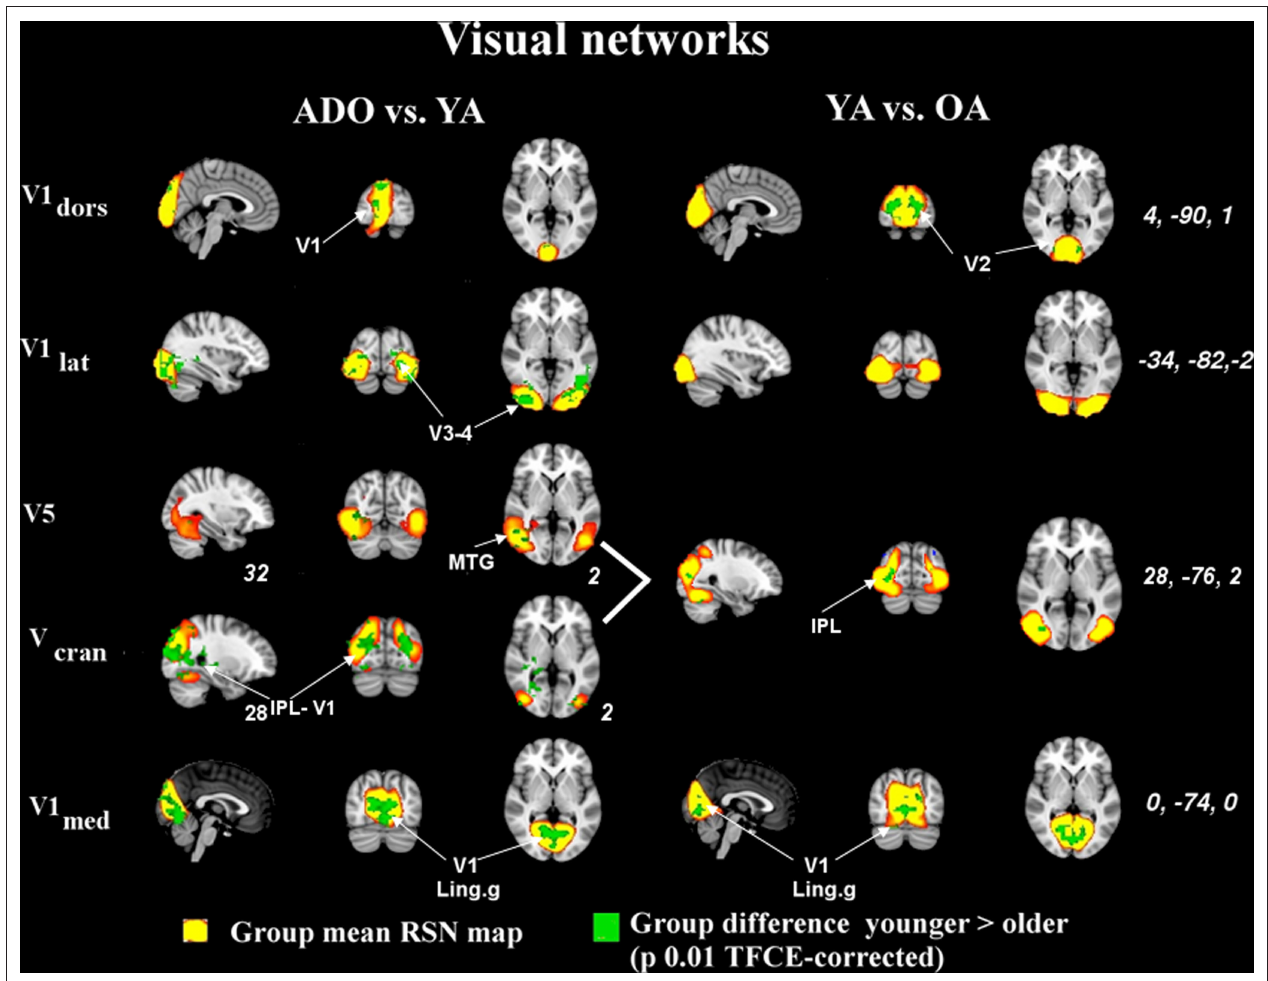
older age groups. V5 and Vcran fuse in the older age group into a single large source. IPL, inferior parietal lobule; MTG, medial temporal gyrus; Ling g, lingual gyrus; V1, primary; V2, secondary; V3, tertiary, and, V4, quadrature visual cortex,